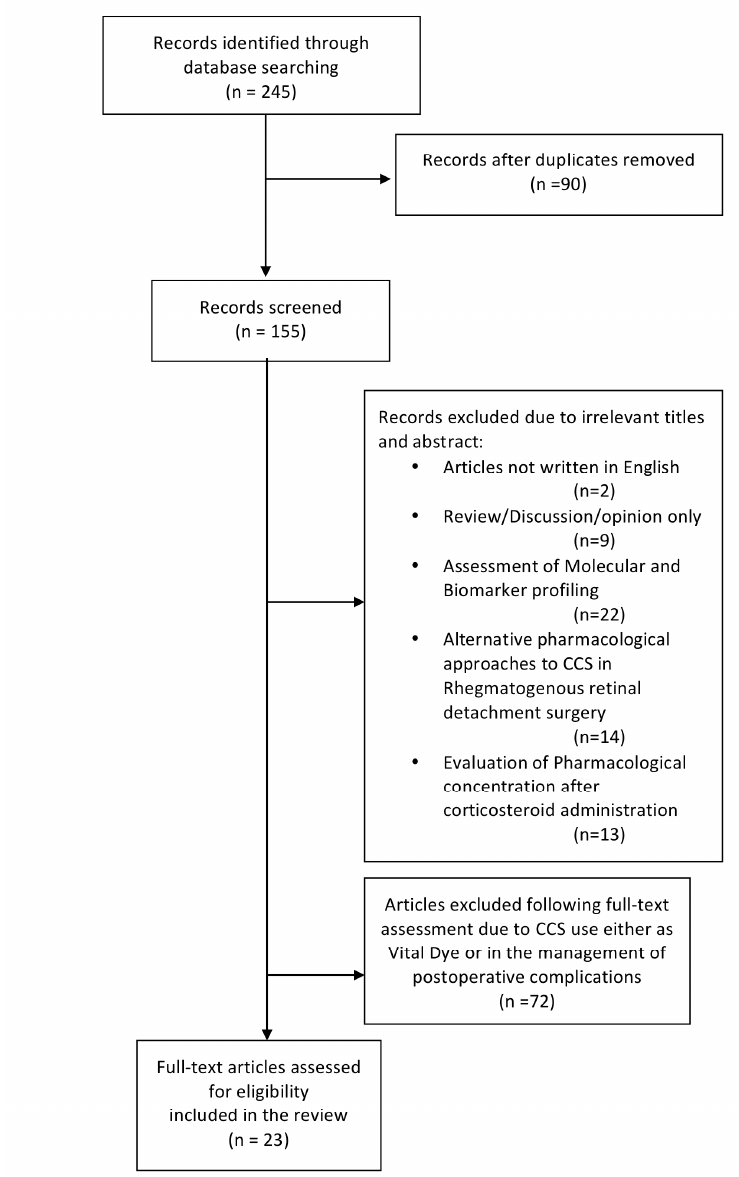
Figure 1. Study selection